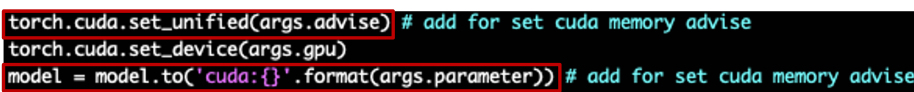
Figure 4. PyTorch code to copy model to the GPU.